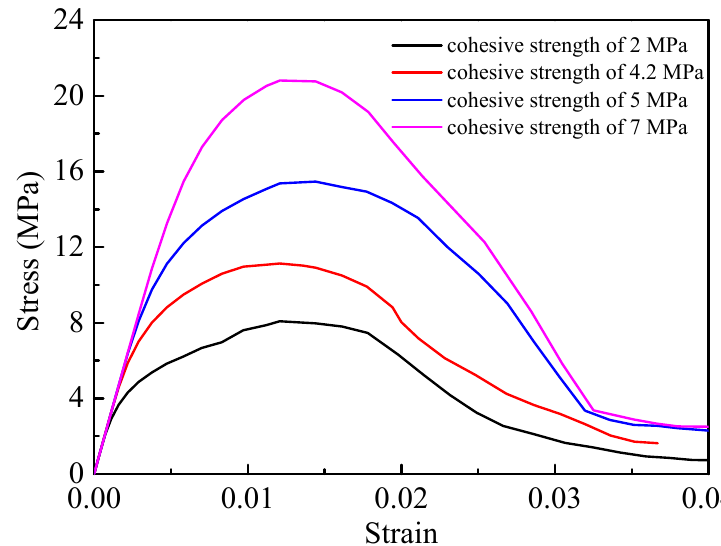
Figure 22. Stress–strain curves of the models with different interface strengths under uniaxial compression at a strain rate of 10 − 2 s − 1 .